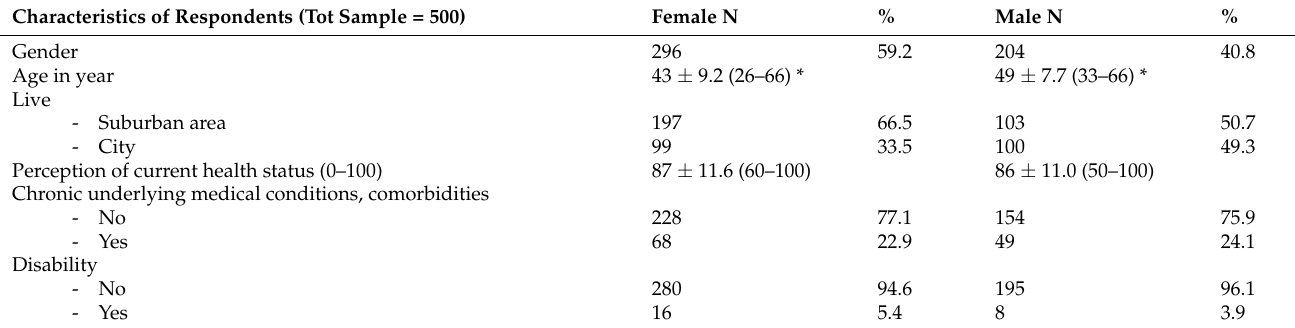
Table 1. Respondents’ socio-demographic and anamnestic